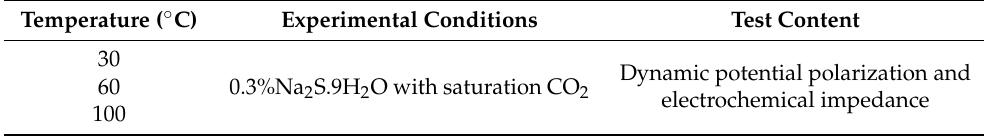
Table 4. Electrochemical experimental